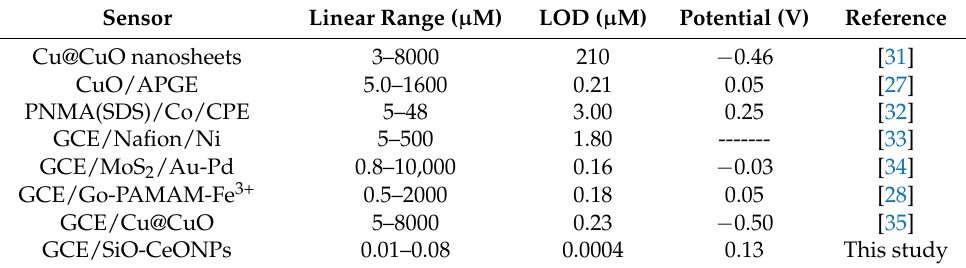
Table 2. Comparison of the proposed methodology with other DPV-reported methods and previous results for the determination of H 2 O 2.